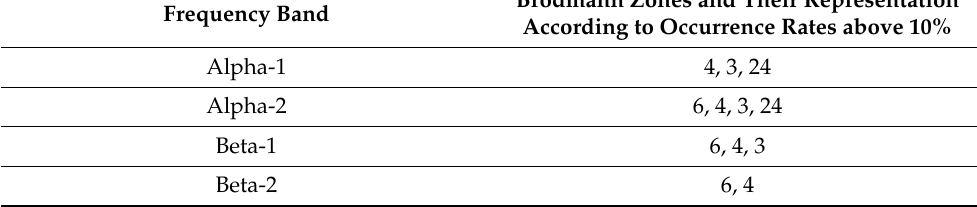
Table 3. Statistically significant Brodmann zones in status prior to stimulation (PRE CE) vs. post- stimulation (POST CE 1).